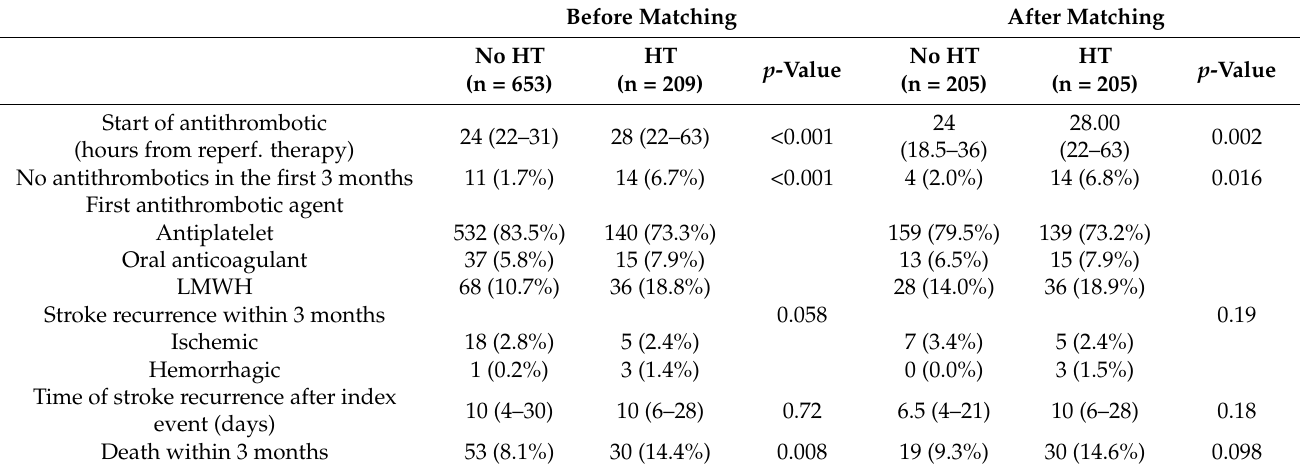
Table 2. Comparison of outcomes between no HT group and HT group before and after matching. Before